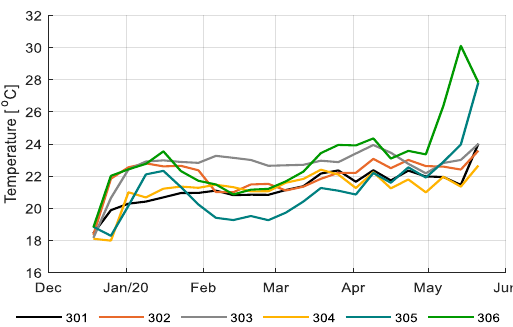
Figure 3. Weekly average temperature (°C) in the six greenhouse compartments (301–306).